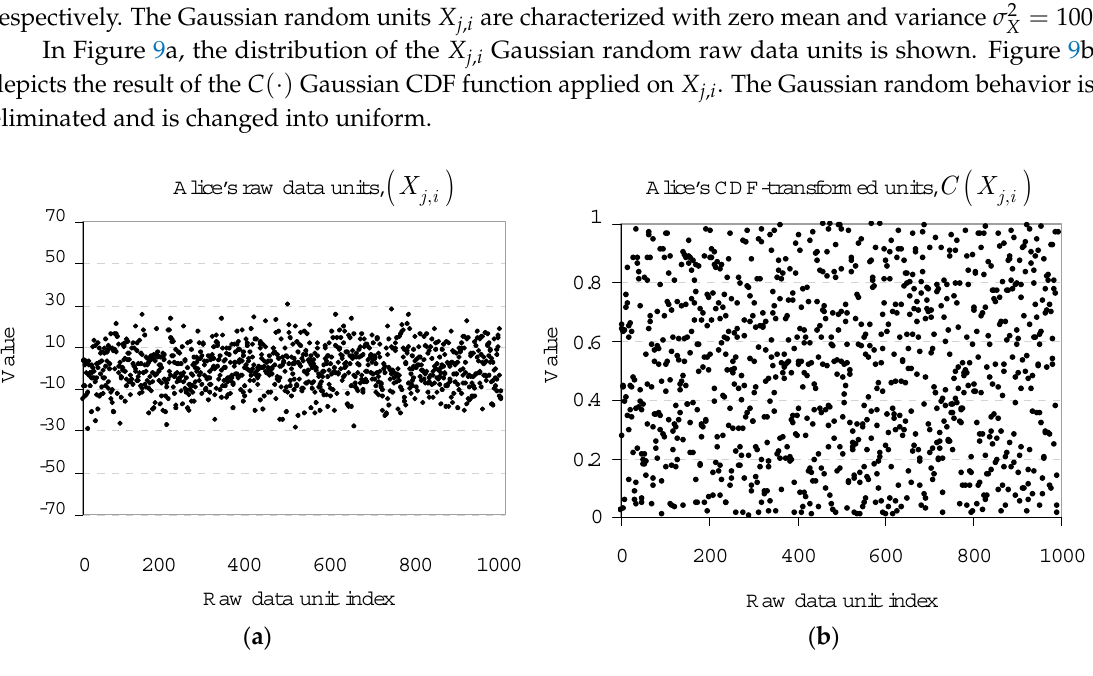
Figure 9. ( a ) The distribution of Alice’s raw data units. The units follow Gaussian random distribution; ( b ) The distribution of the Cumulative Distribution Function (CDF)-transformed units. The probability distribution has changed into uniform in the range of [ 0,1 ]